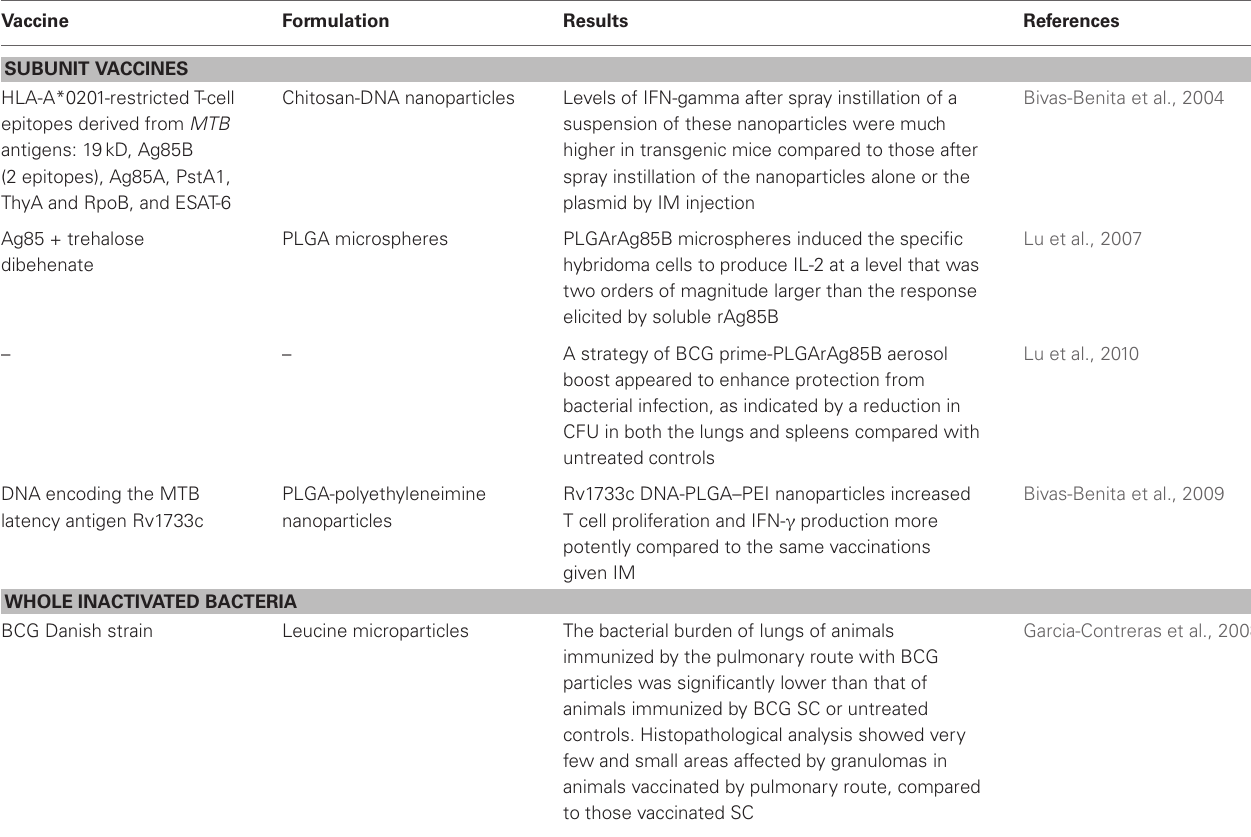
Table 2 | Novel anti-TB vaccine formulations for pulmonary administration.